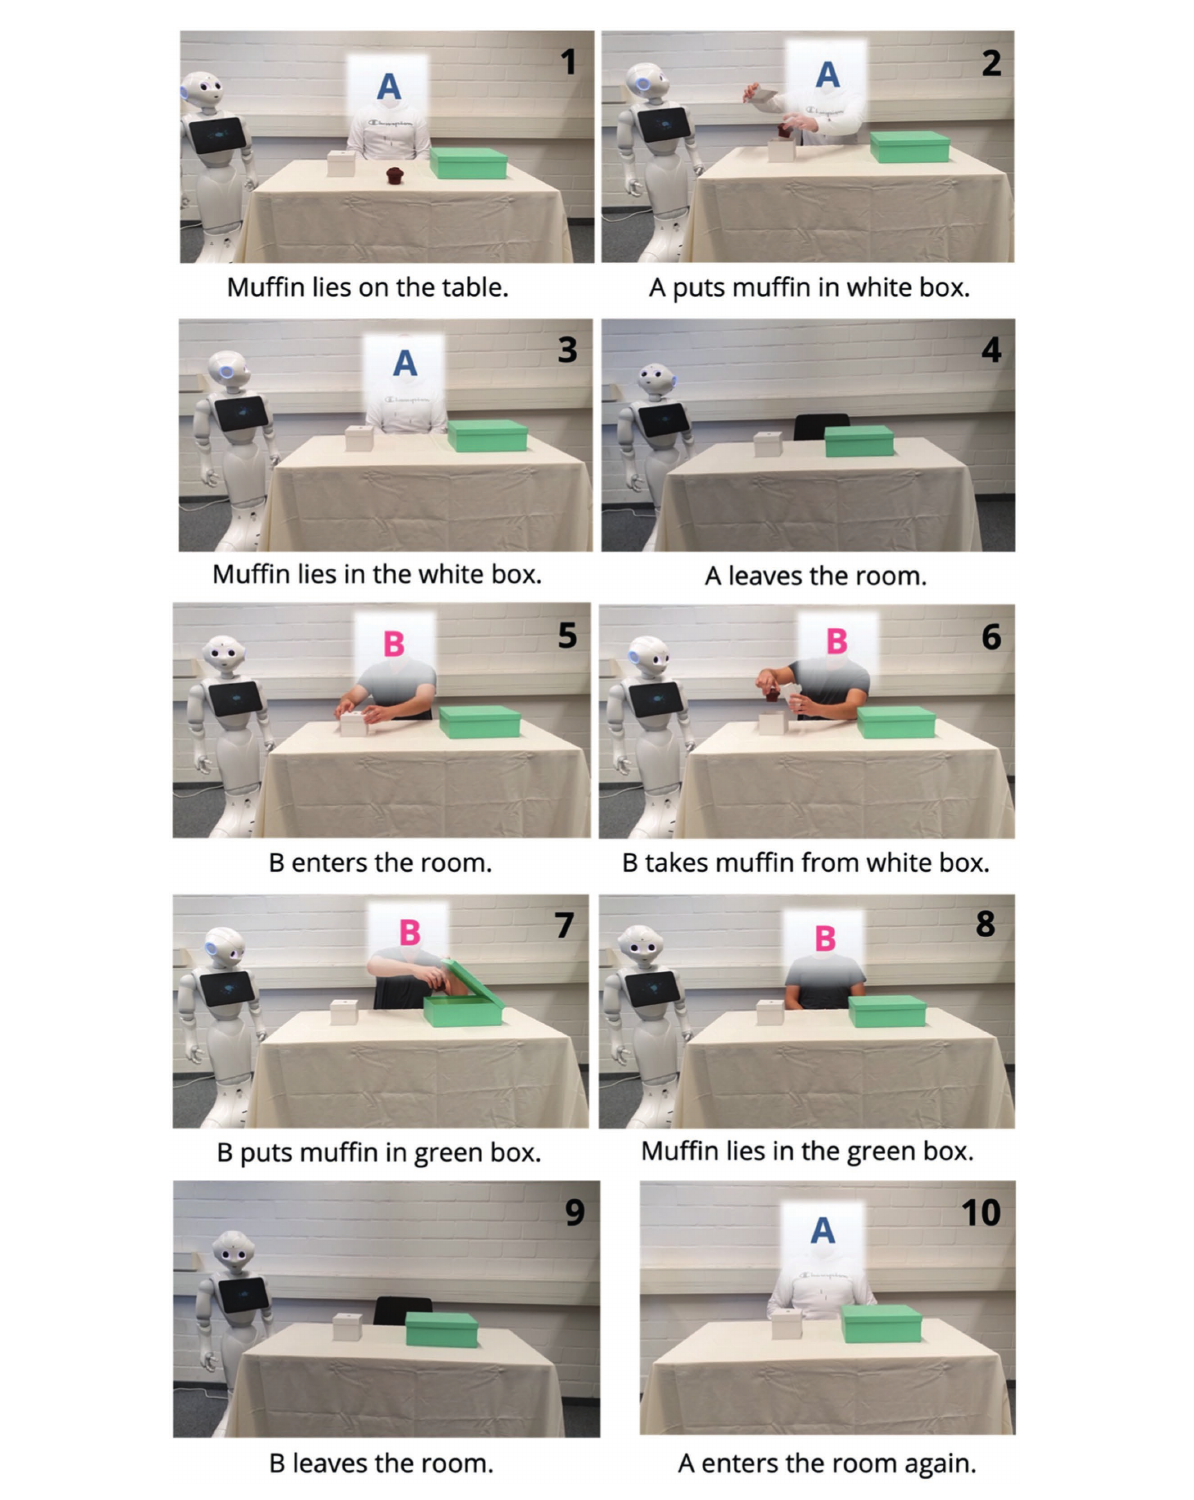
FIGURE 2 First of three picture stories shown to demonstrate the robot’s mentalizing abilities